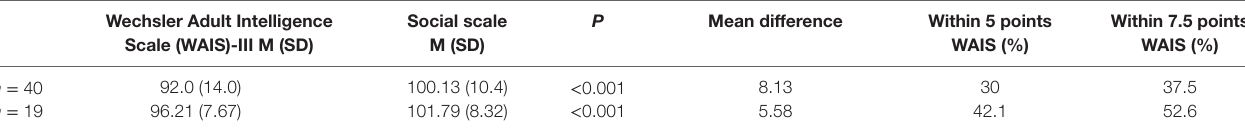
TaBle 2 | Means and classification accuracy of the WAIS-IV and the socio-demographic estimation scale. Wechsler adult intelligence scale (Wais)-iii M